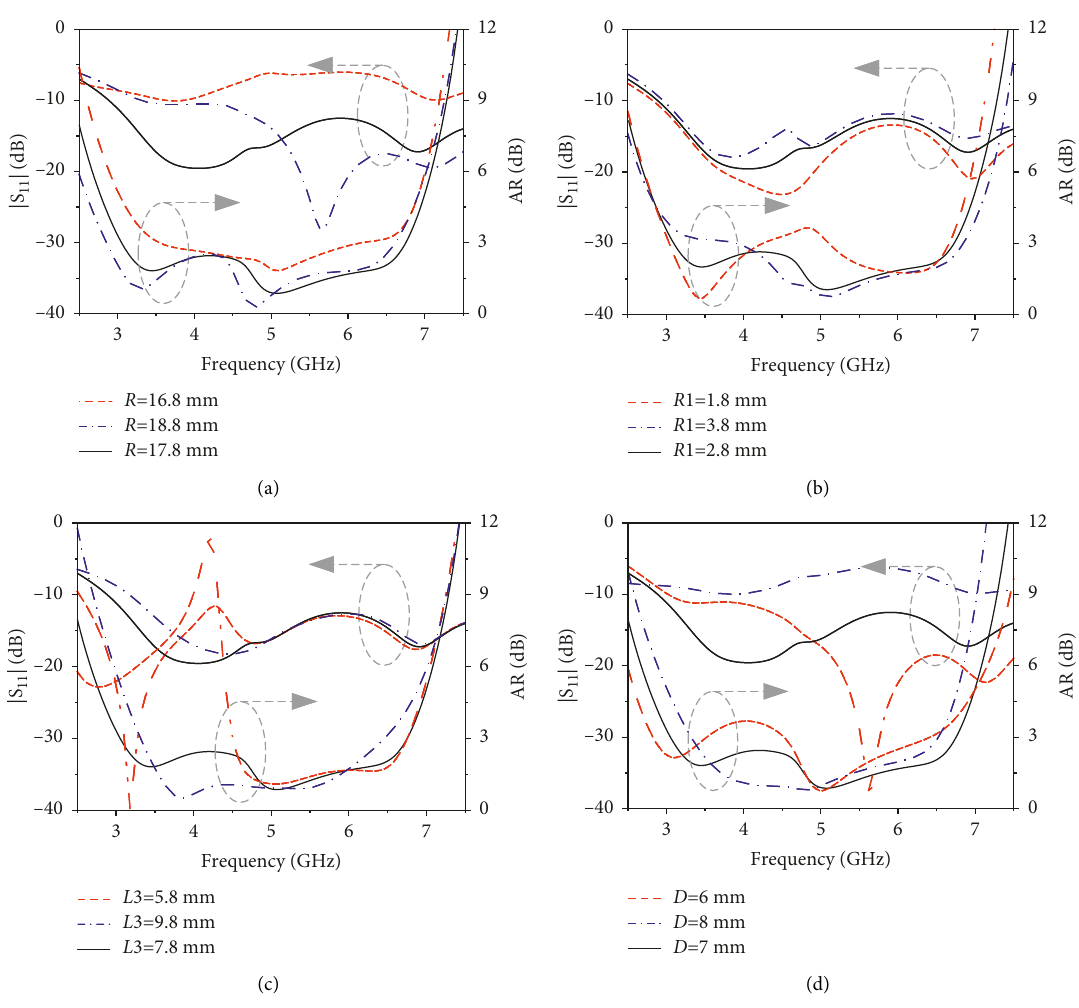
Figure 5: Impact of changing parameters on the | S 11 | and the AR values, (a) R , (b) R 1, (c) L 3, and (d) D . Table 2: Dimensions of the presented